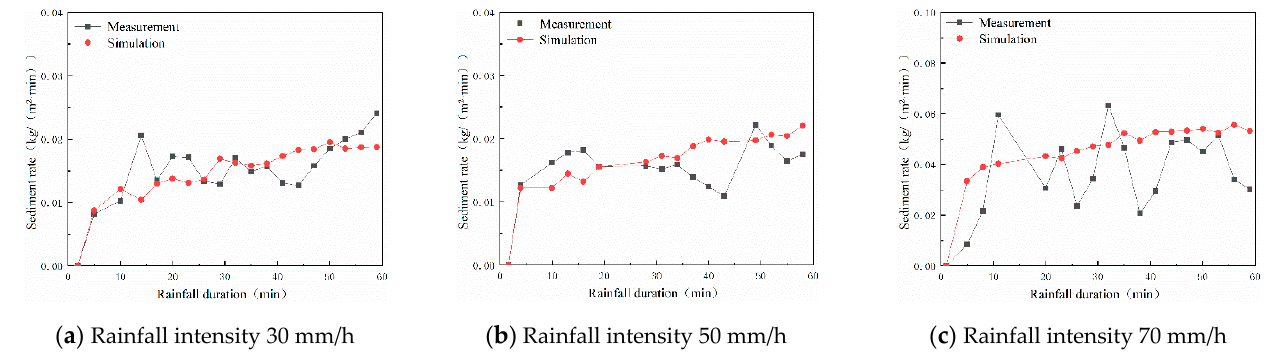
Figure 10. Comparison between measured and simulated sediment rates under different rainfall intensities.